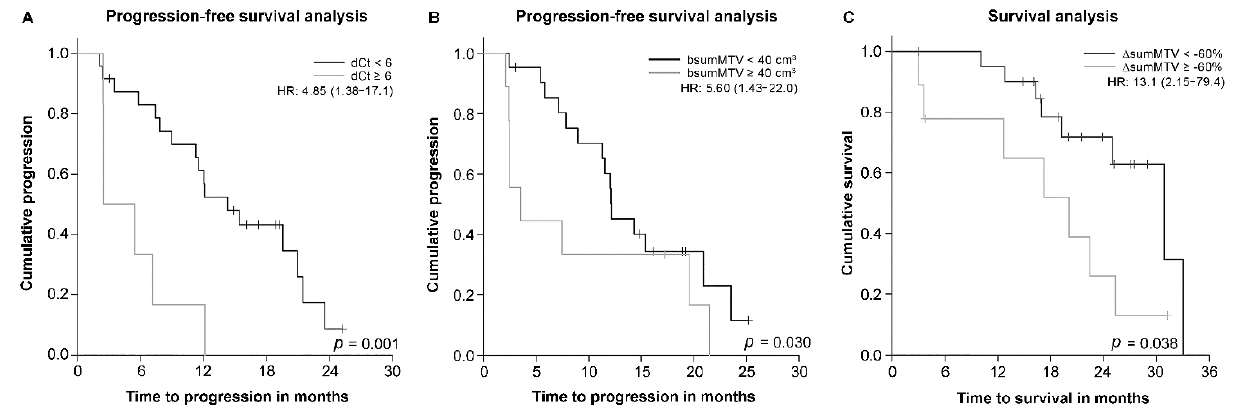
Figure 3. Kaplan–Meier survival curve showing differences in progression-free survival between patients with a dCt of ≥ 6 and those with a dCt of <6 ( A ) and between patients with a bsumMTV ≥ 40 cm 3 and < 40 cm 3 ( B ). ( C ) Kaplan–Meier survival curve showing differences in overall survival between patients with a Δ sumMTV of ≥− 60% and those with a Δ sumMTV of < − 60%. HR, hazard ratio.